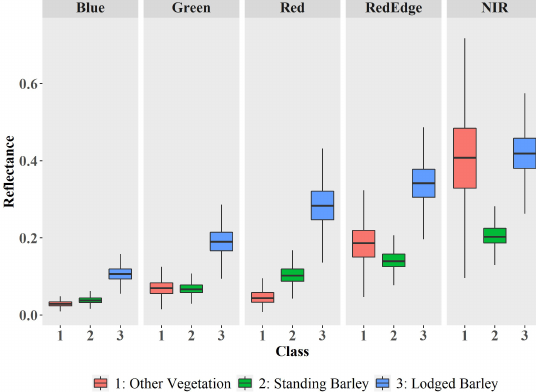
Figure 6. Boxplots of the mean reflectance values of each class extracted from the training areas